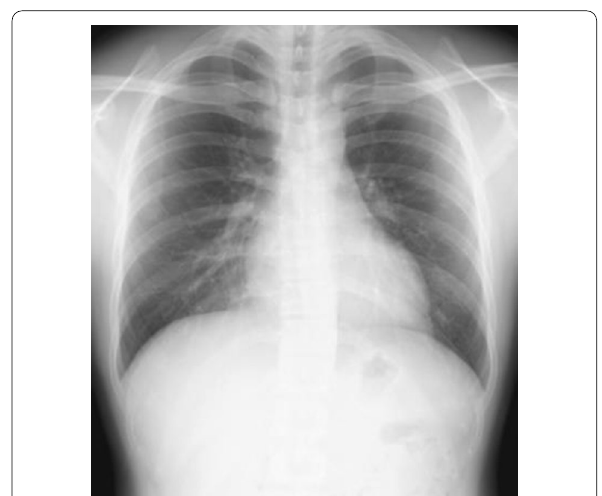
Fig. 3 Postoperative chest radiograph 1 year after